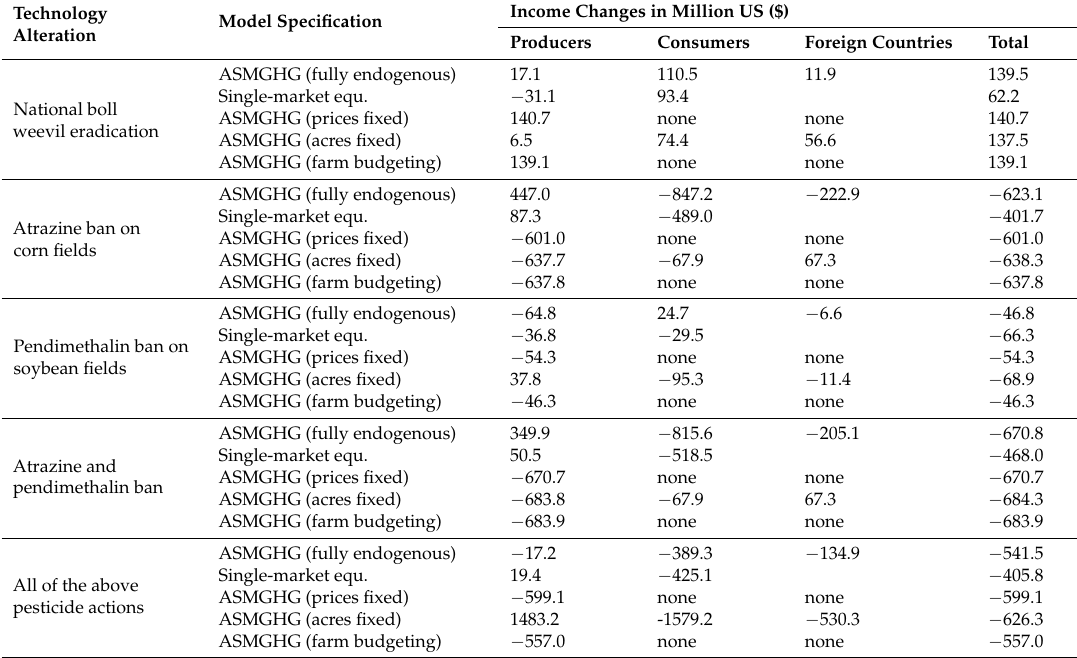
Table 1. Estimates of welfare changes after technology alterations under different assumptions about market responses. For price-exogenous methods, the change refers to income changes for